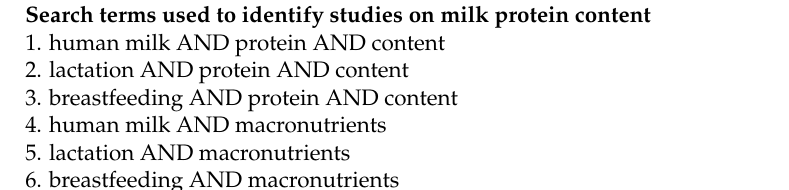
Table 1. Search strategies and terms used to identify studies for this